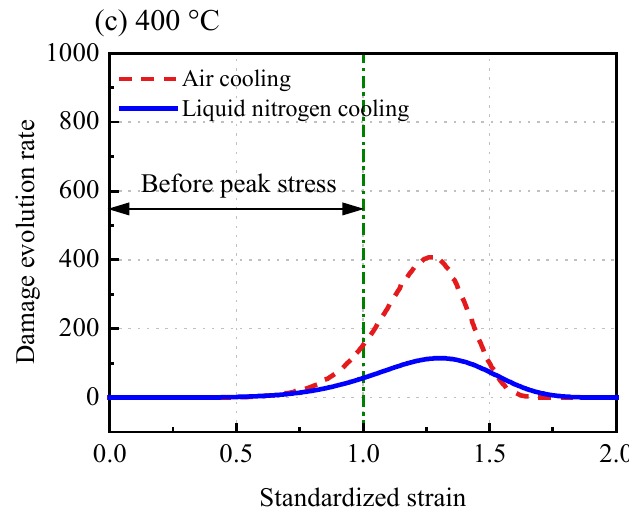
Figure 10. Damage evolution rate versus standardized strain.